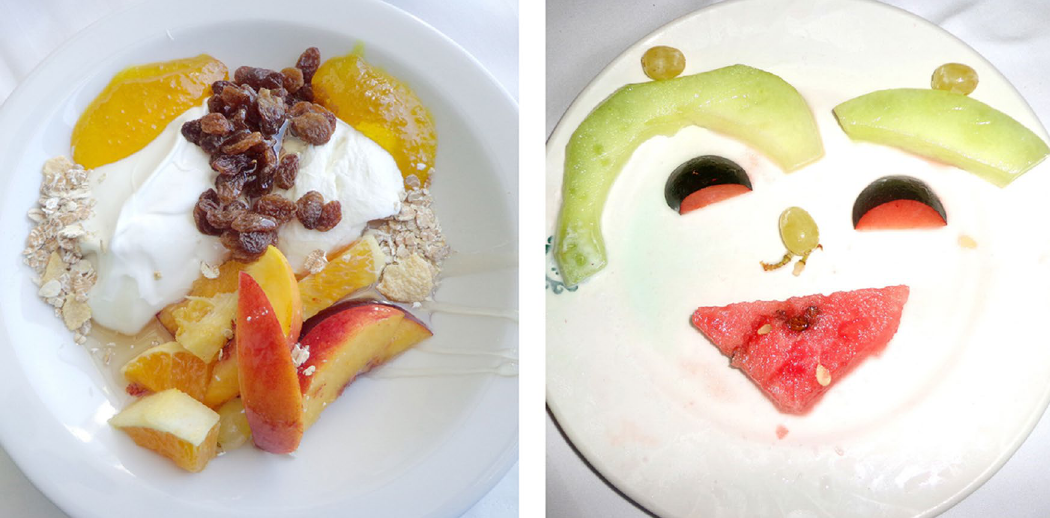
Figure 2. Examples of Face-n-Food images. The least resembling face (left panel) and most resembling face (right panel) images from the Face-n-Food task (from Ref. 61 ; the Creative Commons Attribution [CC BY]